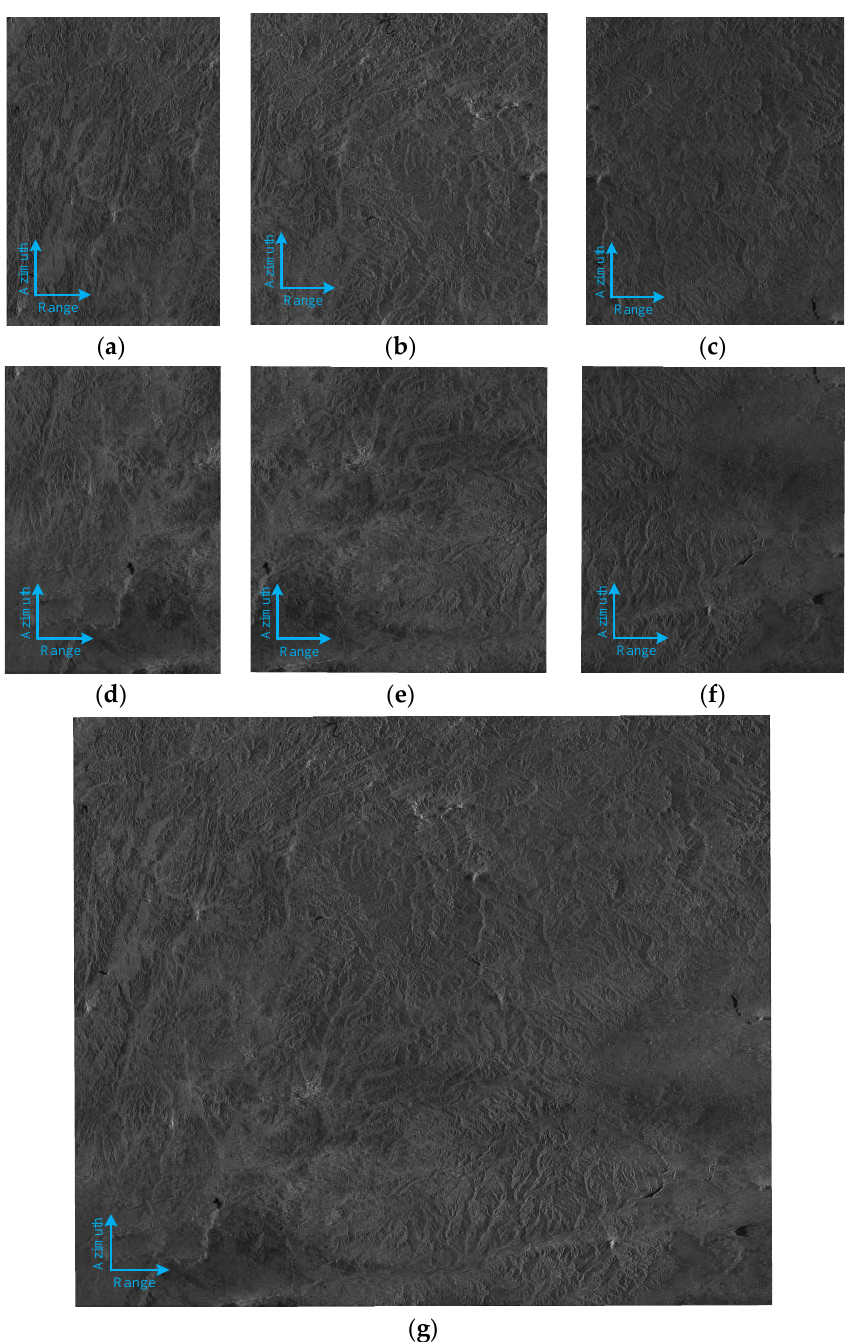
Figure 11. GF-3 ScanSAR images: ( a ) Azimuth1_subswath1; ( b ) Azimuth1_subswath2; ( c ) Azimuth1_subswath3; ( d ) Azimuth2_subswath1; ( e ) Azimuth2_subswath2; ( f ) Azimuth2_subswath3; ( g ) mosaic result of the six GF-3 spaceborne ScanSAR images.